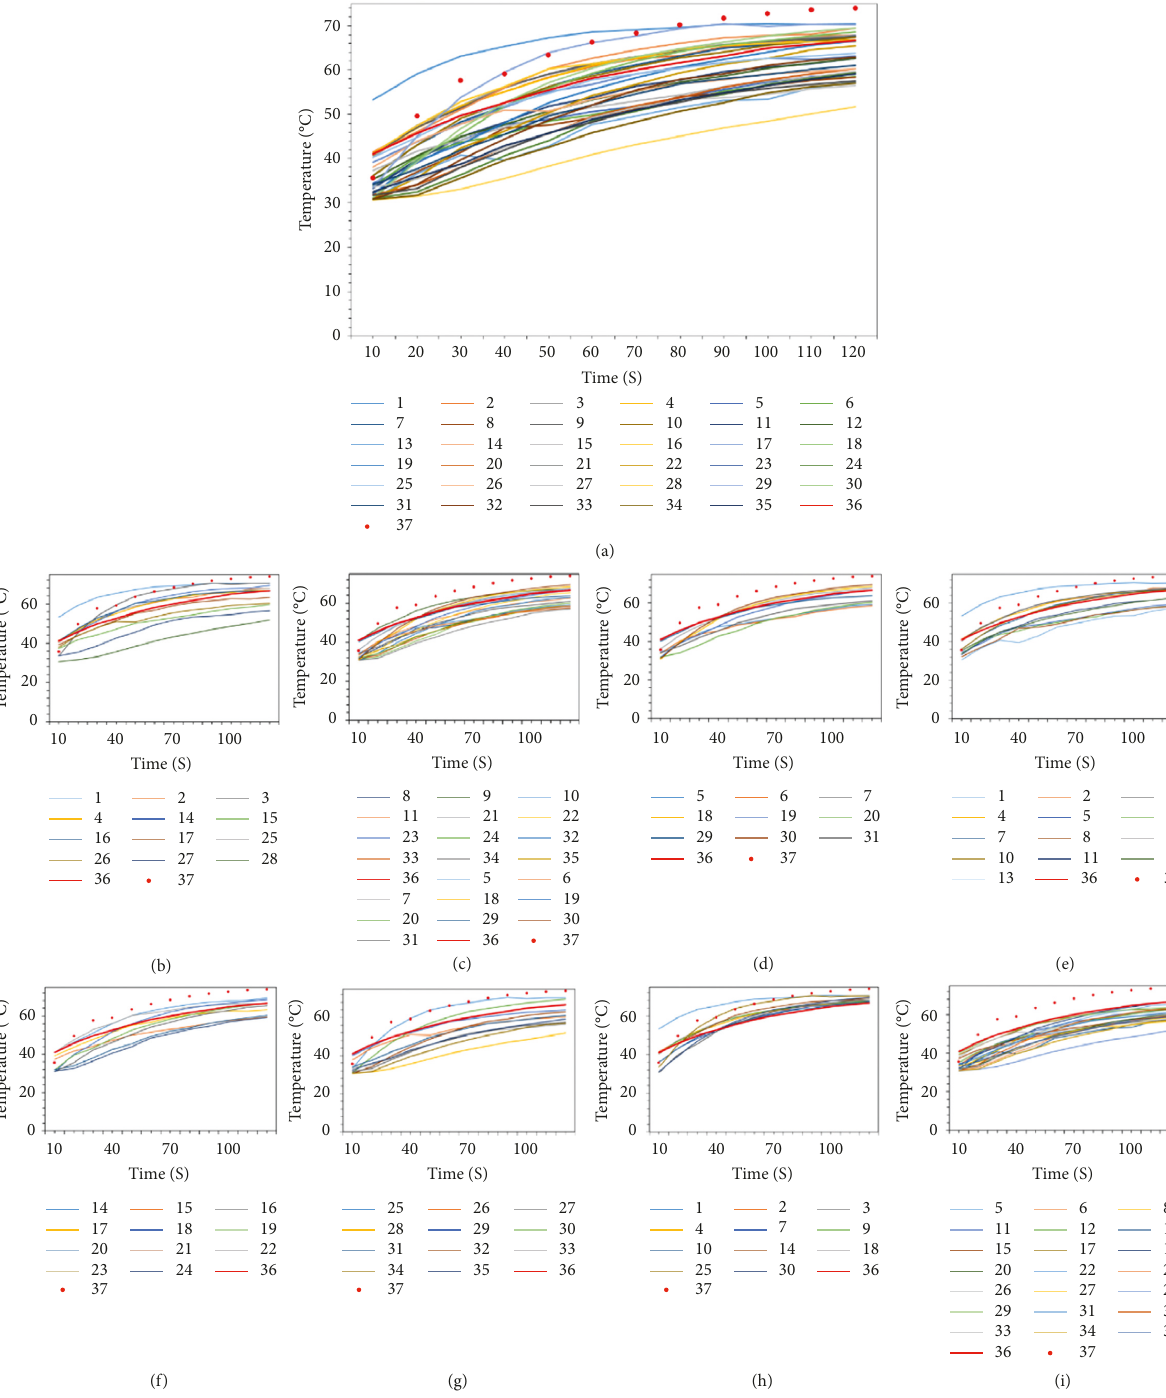
Figure 2: Thermal behavior of manufactured laminates. (a) General; (b) containing CF and NHF; (c) containing CF, GF, and NHF; (d) containing CF and GF; (e) containing 10g of Al 2 O 3 ; (f) containing Al; (g) containing only resin; (h) with a temperature higher than that of sample 36; and (i) with a temperature lower than that of sample